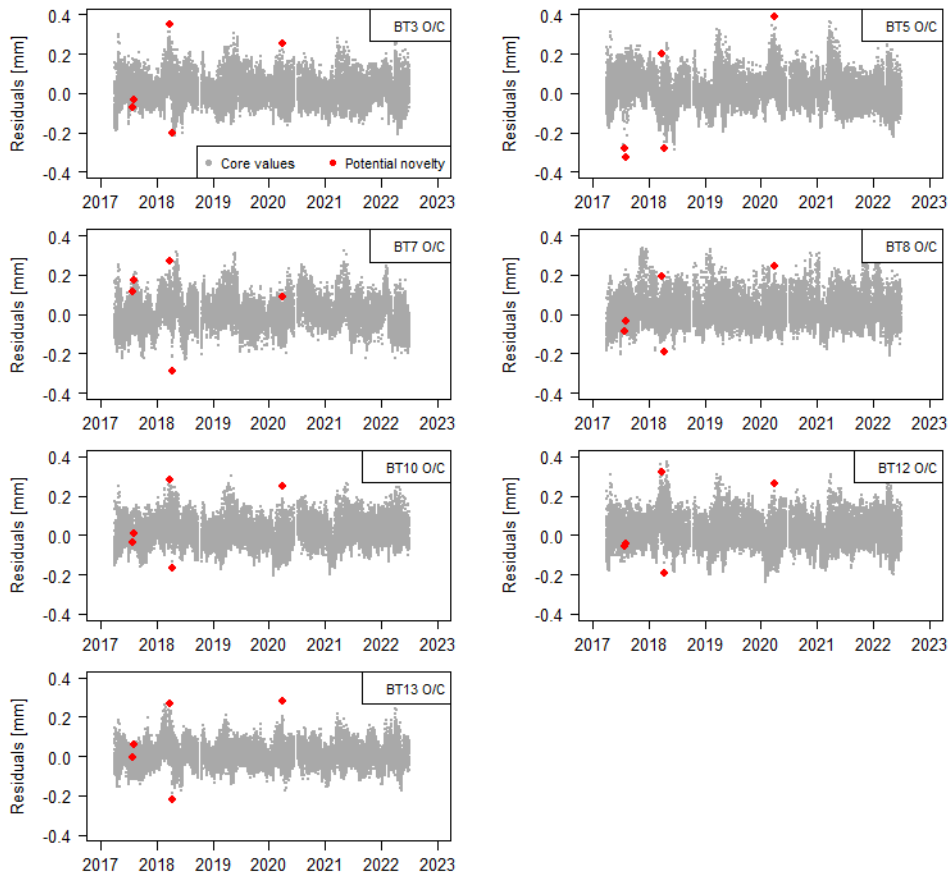
Figure 18. Novelty identification based on a multivariate analysis based on the DBSCAN method (adopting Epsilon = 0.12 and MinPoints =